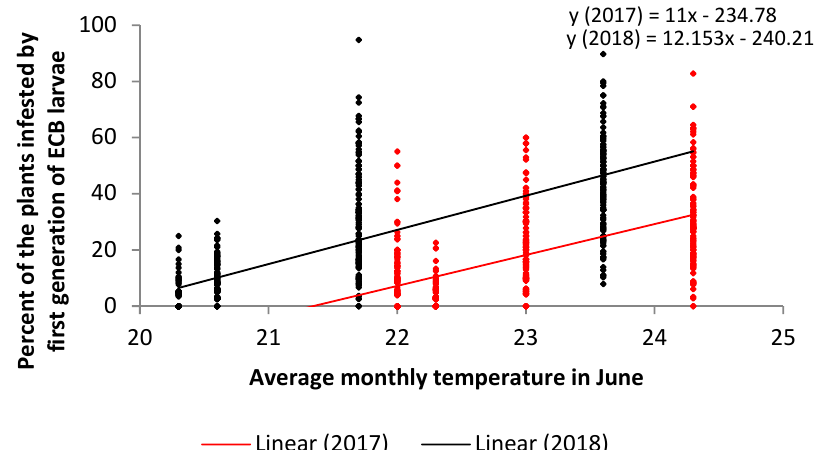
Figure 1. Regression analysis of the average monthly temperature in June (x) versus the percent of infestation with first generation of ECB larvae (y) in two years (2017—red and 2018—black).